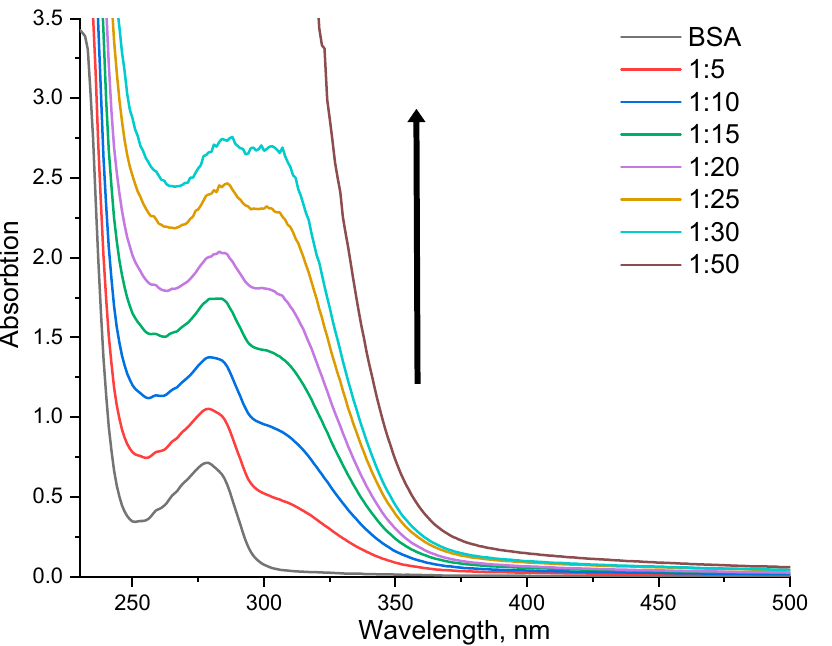
Figure 14. Graphs of the absorption spectra of aqueous solutions of BSA upon the titration with Eu(III) complex 10a . The arrow shows grow of the intensity of the absorption of the proposed complex “BSA:10a” upon increasing concentration of 10a .